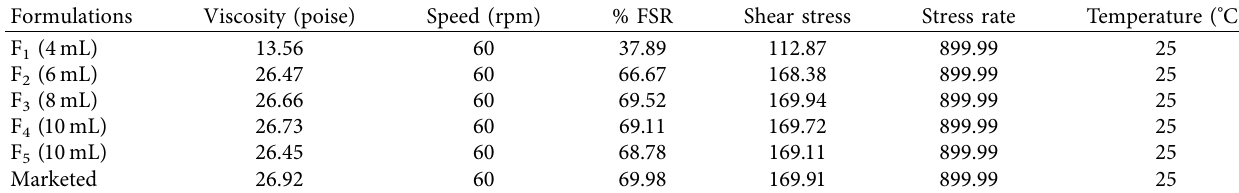
Table 7: Viscosities of A. elegans gel